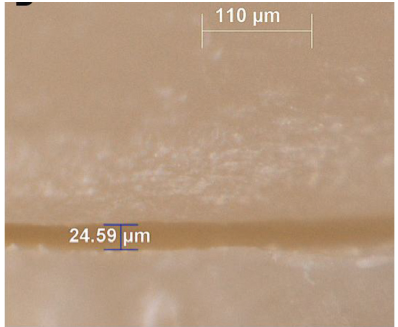
Figure 3: Measurement of marginal gap using a stereomicroscope (Leica MZ 16A, Leica Microsystems, Switzerland), Lava Ultimate inlay, distal.